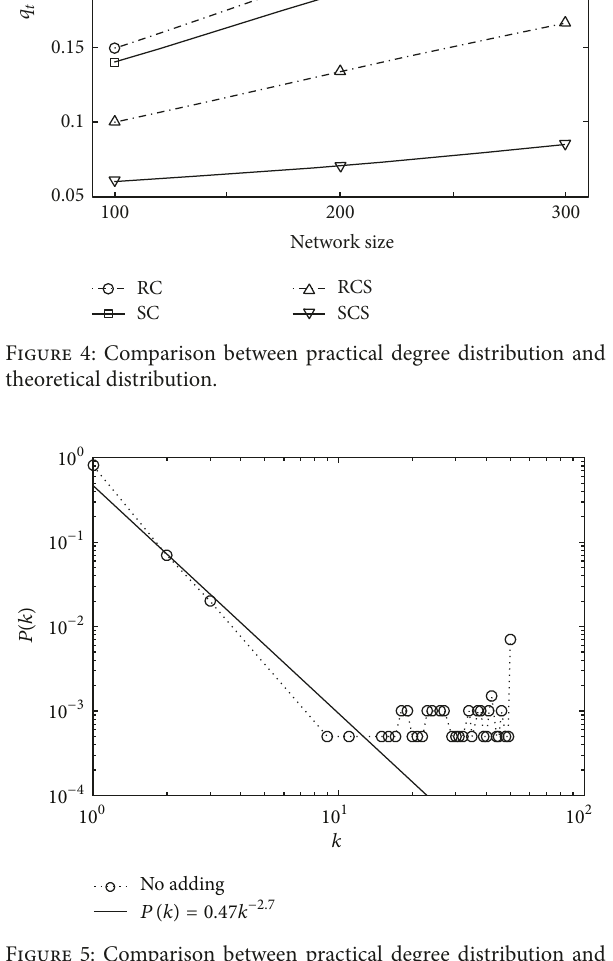
Figure 5: Comparison between practical degree distribution and theoretical